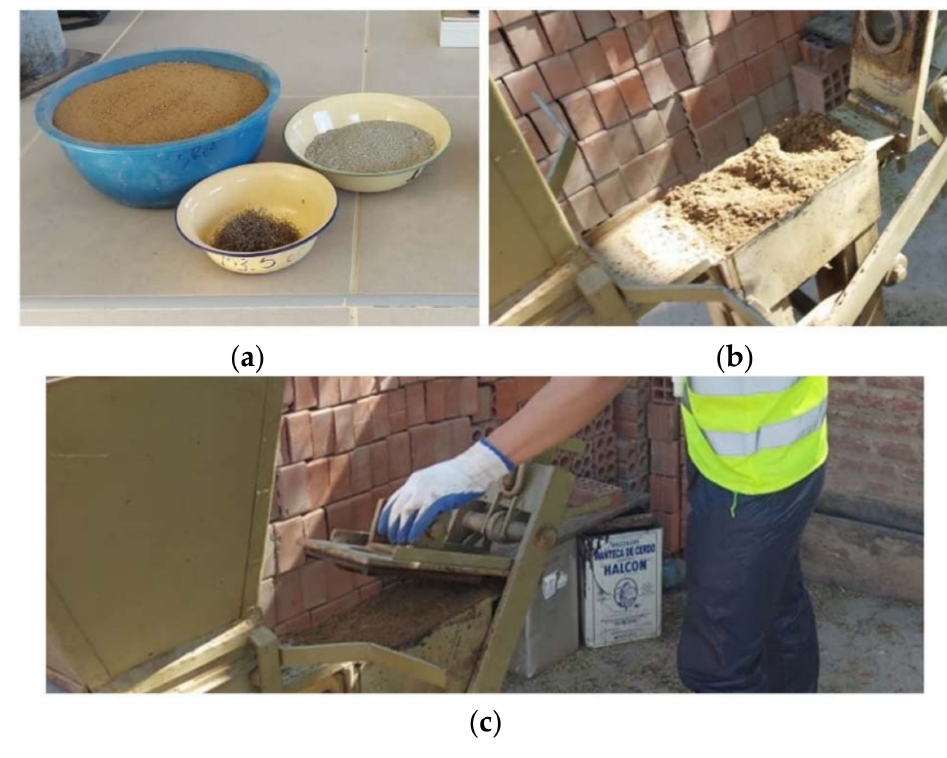
Figure 4. Preparation of soil–cement blocks: ( a ) preparation of materials, ( b ) placement of mixture, and ( c ) compaction.